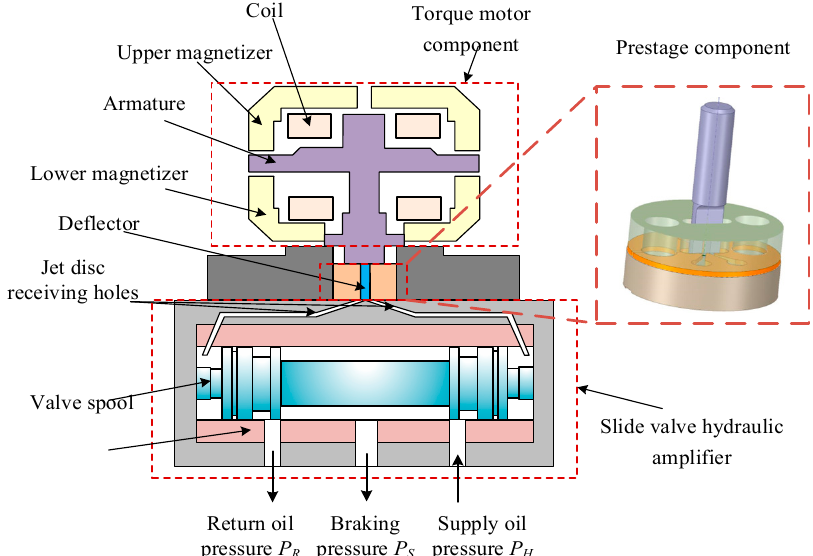
Figure 1. Schematic diagram of the DJSV.